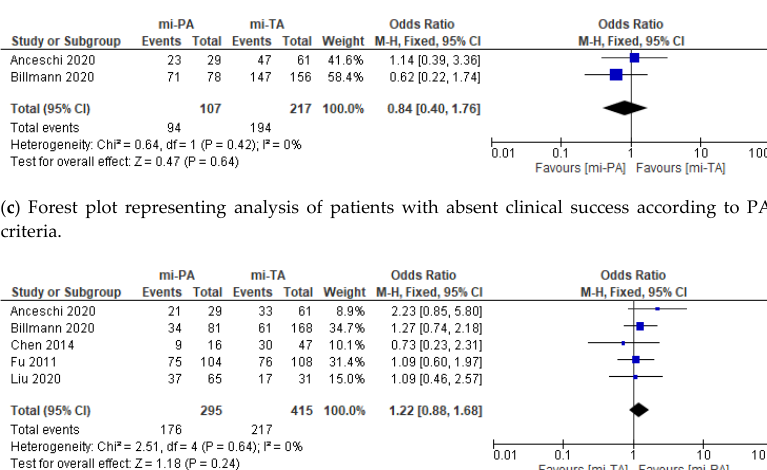
J. Clin. Med. 2022 , 11 , 1263 11 of 17 ( b ) Forest plot representing analysis of patients with partial clinical success according to PASO criteria.